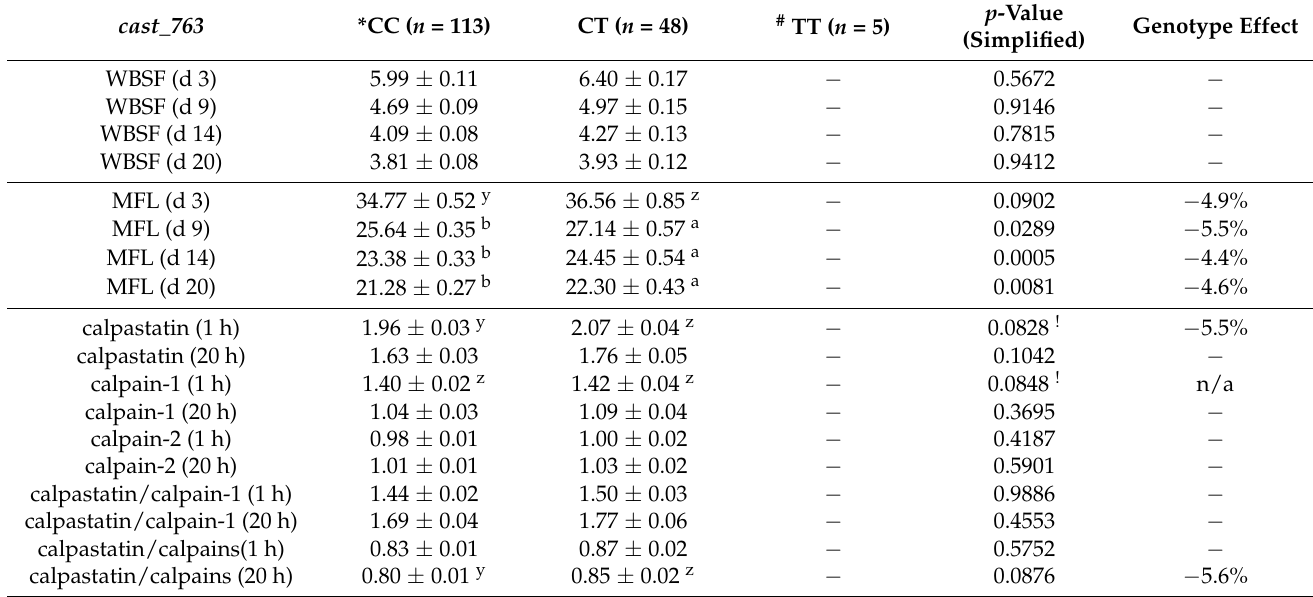
Table 3. The effects of genotype of the cast_763 SNP on the tenderness phenotypes, Warner–Bratzler shear force (WBSF) and myofibril fragment length (MFL) of representative purebred South African beef bulls during three to 20 days of ageing and on the muscle protease enzyme system during the first 20 h